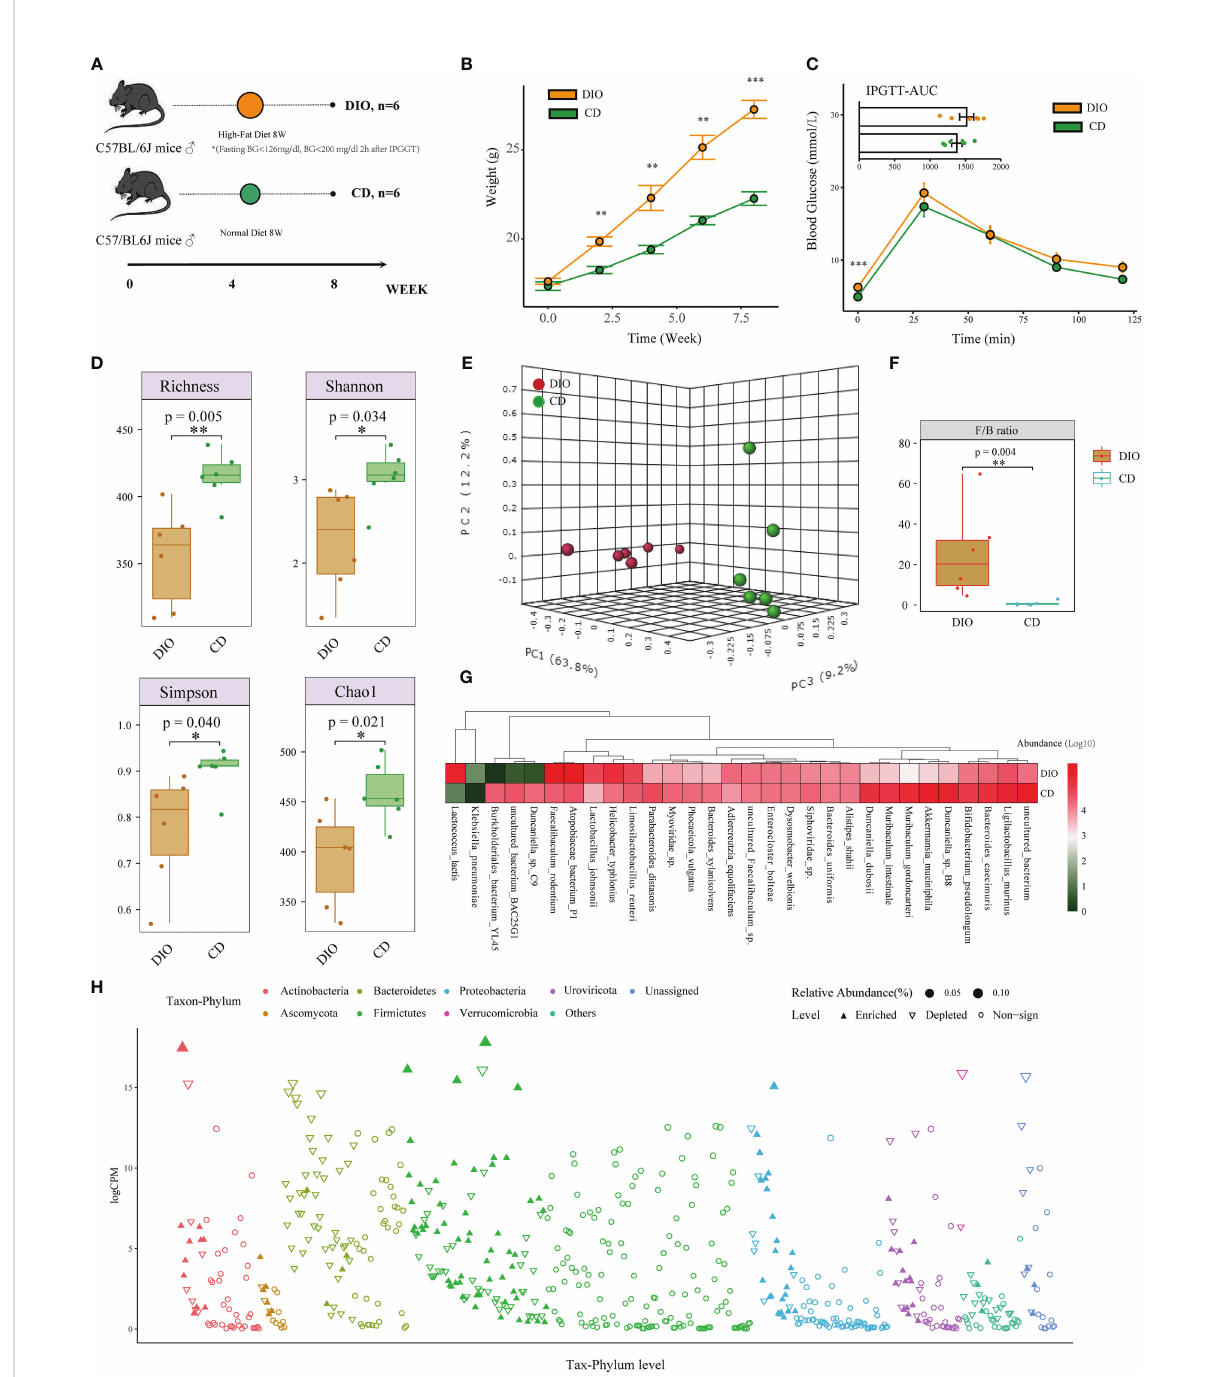
FIGURE 3 Alteration of Taxonomic Composition in MHO Mice. (A) Experimental design of mice. (B) Metabolic parameters of body weight (B) and IPGTT (C) were examined at the beginning of the 9th week. (D) Alpha diversity was evaluated by observed Richness, Shannon index, Simpson index, and Chao1 using the Student ’ s t -test. (E) PCoAs of b -diversity with the 3-dimensional presentation. (F) Firmicutes/Bacteroidetes ratio was compared using the Mann-Whitney U test between MHO and controls. (G) Heatmap visualization of the top 30 abundant species in MHO and controls. (H) Manhattan plots showing the changed composition of species in MHO by the edgeR algorithm. The color of each dot represents the different taxonomic af fi liations of the species (phylum level), and the size corresponds to their relative abundance. The Y-axis represents log counts per million(CPM). The upward-pointing triangle indicates enriched species, whereas the downward-pointing triangle represents depleted ones. * p 0.05 ** p 0.01 *** p